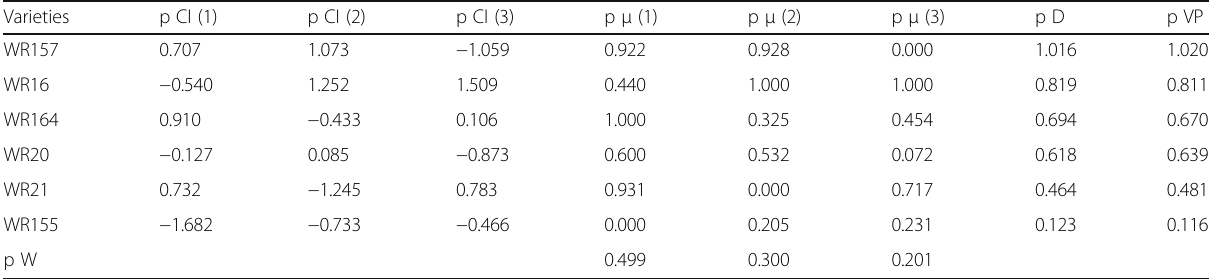
Table 3 The different value of comprehensive evaluation of each variety